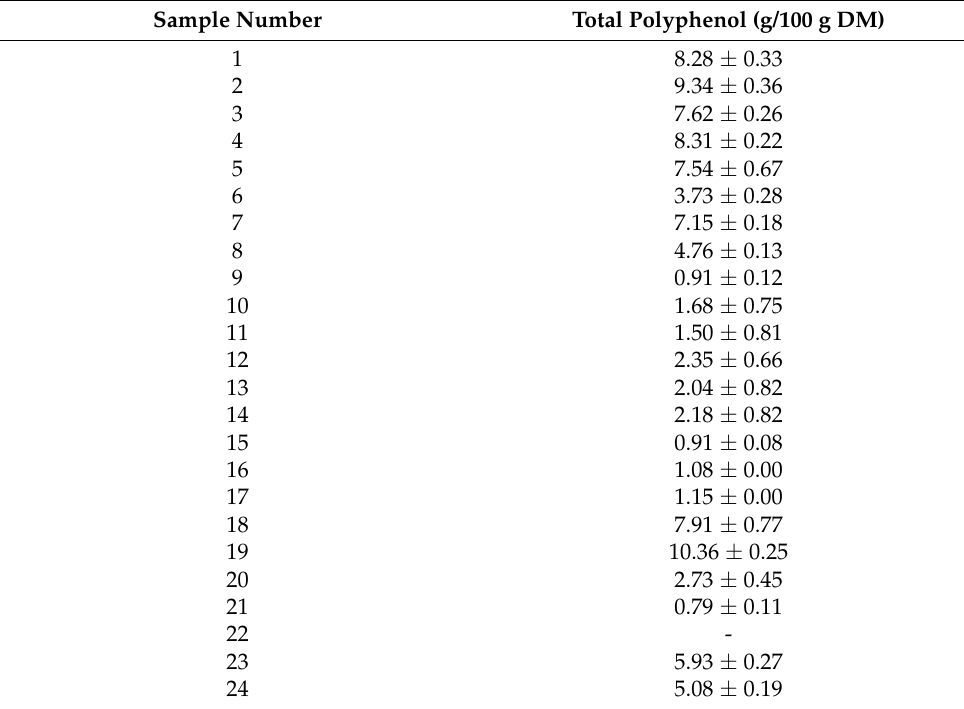
Table A3. Results of the photometric analysis of the total polyphenol